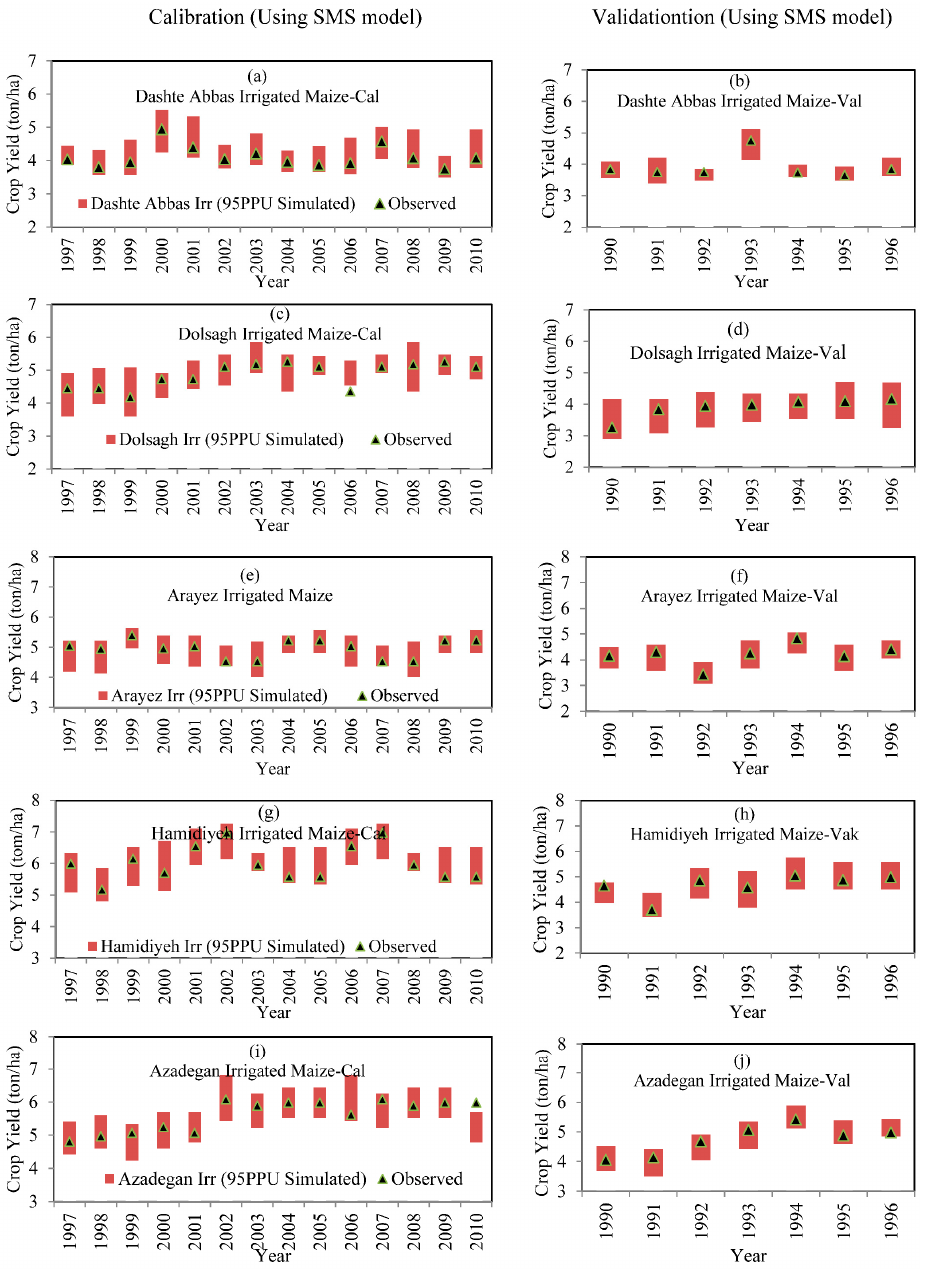
Figure 6. Results of the SMS calibration and validation for maize yield in Dashte Abbas ( a , b ), Dolsagh ( c , d ), Arayez ( e , f ), Hamidiyeh ( g , h ), Azadegan ( i , j ) plains. Dolsagh ( c , d ), Arayez ( e , f ), Hamidiyeh ( g , h ), Azadegan ( i , j )